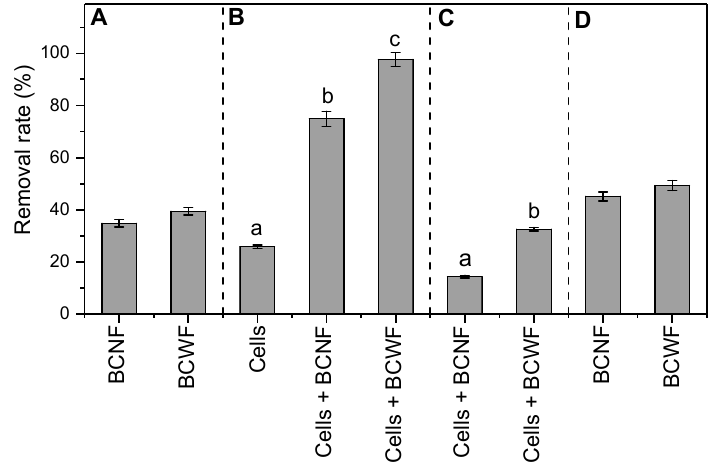
Figure 3. OG removal rates in different treatment systems. ( A ), Removal rates of Orange G in the presence of biochars alone. ( B ), Removal rates of Orange G in the presence of cells alone and in the presence of cells and biochars. ( C ), Rates of the microbially reductive removals of Orange G mediated by biochars. ( D ), Removal rates of Orange G in the presence of microbially reduced biochars. BCNF and BCWF indicate the biochars prepared using peanut stalks from the plot without Fe addition and from the plot with Fe addition, respectively. In ( B ) and ( C ), means followed by the different lowercase letters indicate significantly different at a level of P < 0.05.